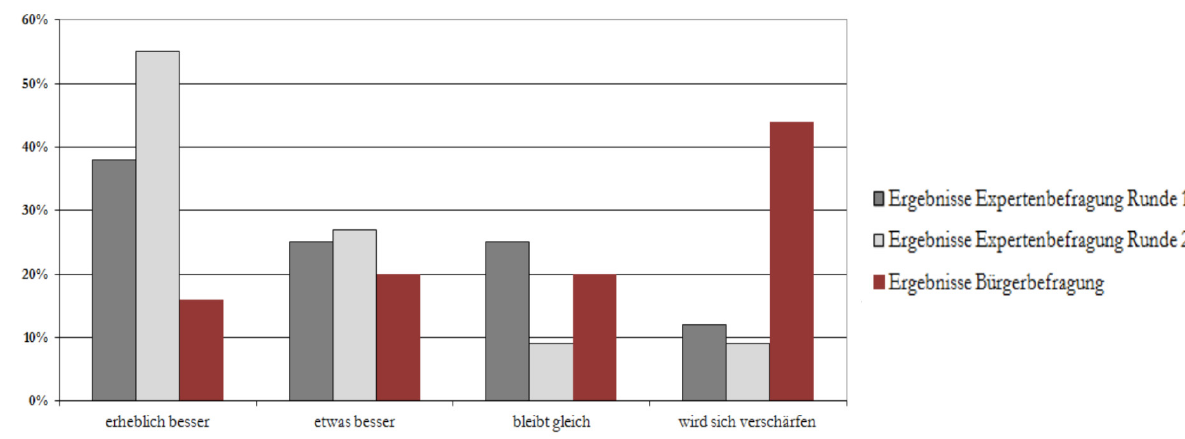
Figure 7: Future development of noise according to experts (round 1 N = 15; round 2: N = 11) and residents (N =